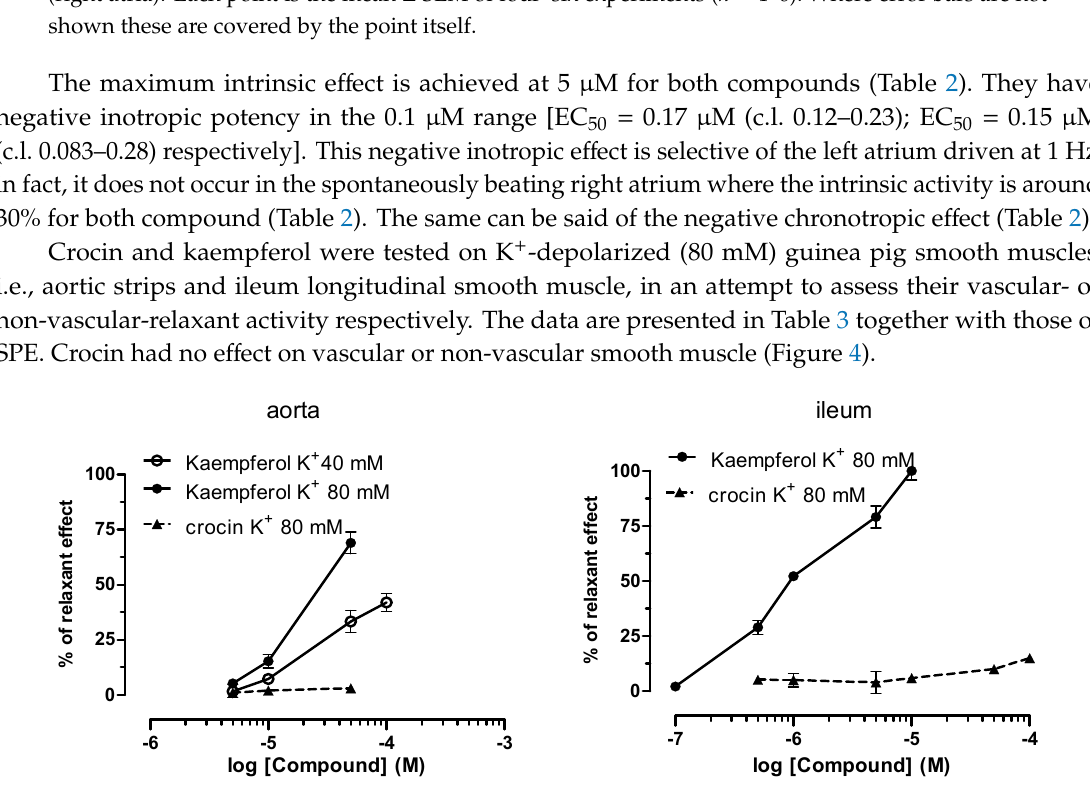
Figure 4. Spasmolytic effect of crocin and kaempferol on high K + -induced contraction on guinea pig vascular (aorta) and non-vascular (ileum) smooth muscle. Cumulative concentration–response curves for crocin and kaempferol were obtained using relaxant effects as percentage of the initial tension induced by 40- or 80-mM K + , taken as 100%. Each point is the mean ± SEM ( n = 5–6). Where error bars are not shown these are covered by the point itself.